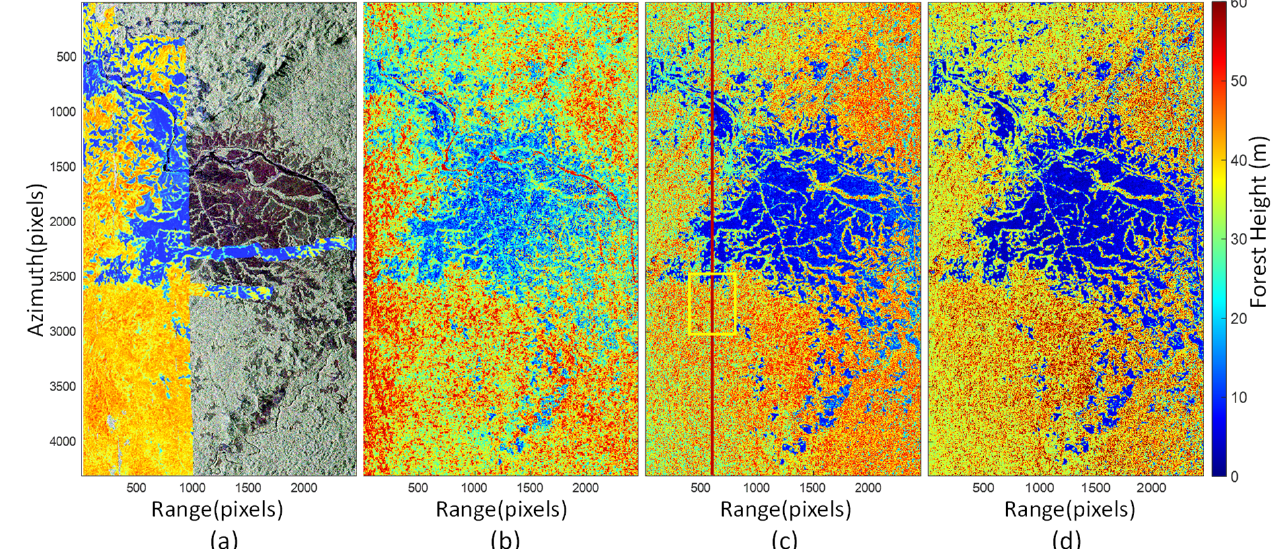
Figure 7. PolInSAR forest height retrieval results for tropical forest at Lope. ( a ) The LVIS LiDAR forest height product is overlaid on the Pauli RGB composite map; ( b ) dual-baseline PolInSAR forest height inversion results based on the RVoG model; ( c ) dual-baseline PolInSAR forest height inversion results based on the PCT model; ( d ) dual-baseline PolInSAR forest height obtained by correcting the height of canopy scattering peak.